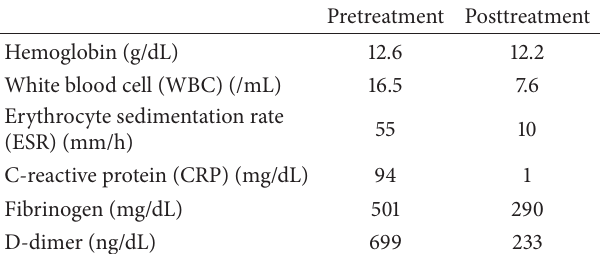
Table 1: Laboratory findings after and before the